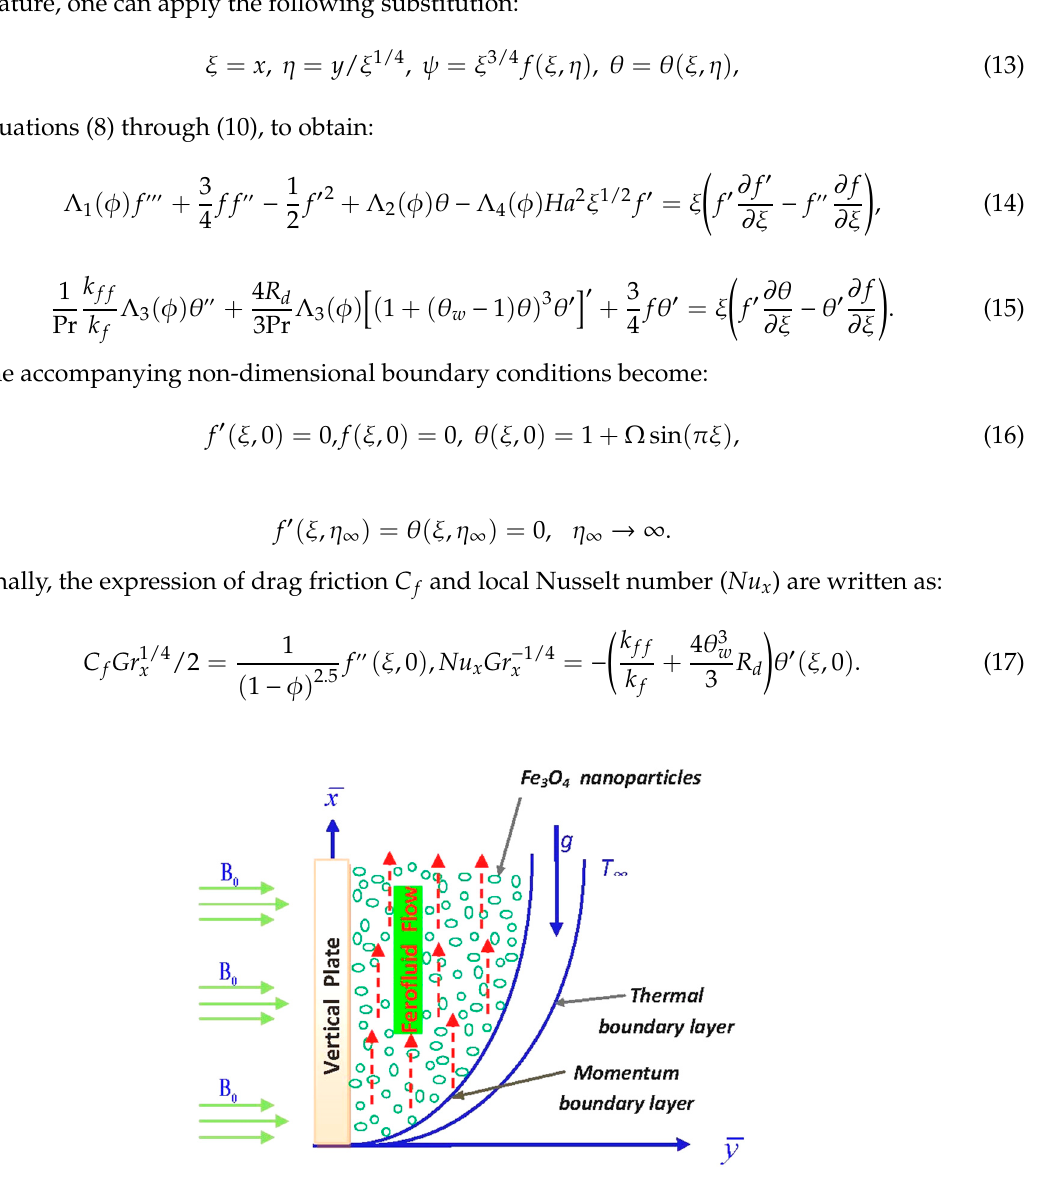
Figure 1. Geometry of the flow process.